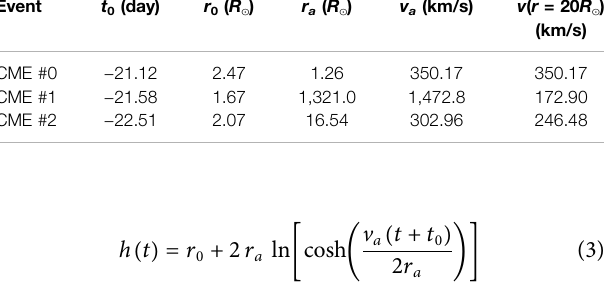
TABLE 1 | Best- fi t parameters for the height – time pro fi les of the three sequential eruptions.